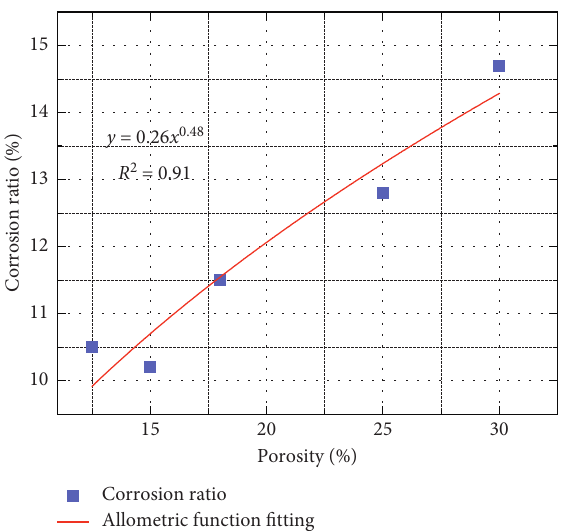
Figure 13: The relation between porosity and corrosion